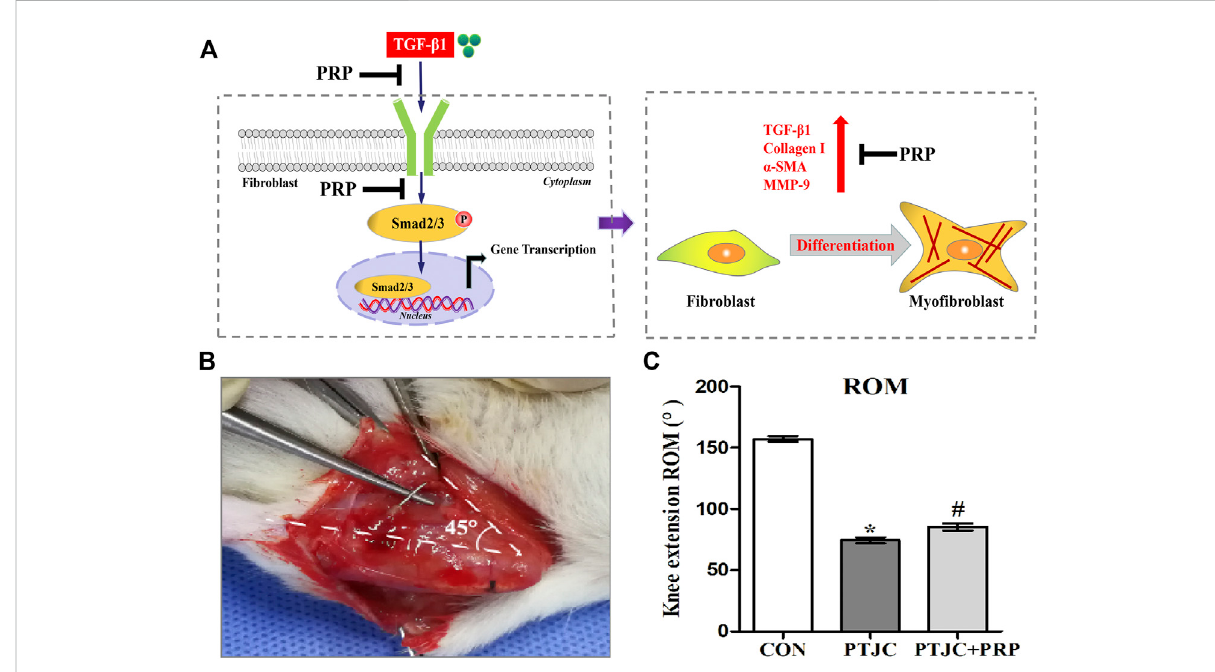
FIGURE 4 PRPinhibitedtheprocessof fi brosis. (A) PatterndiagramofPRPinhibitedTGF- β 1-induced fi brosis.TGF- β 1causedphosphorylationofSmad2/3, up-regulating expression of TGF- β 1, COL- Ⅰ , α -SMA, MMP-9 and promoted fi broblasts transforming into myo fi broblasts. PRP inhibited TGF- β 1- induced fi brosis. (B) Schematic of rat knee joint post-traumatic immobilization. (C) Measurement of extension ROM of the affected knee joint. Error bars represent standard deviation. * p < 0.05 compared with the CON group. # p < 0.05 compared with PTJC group.